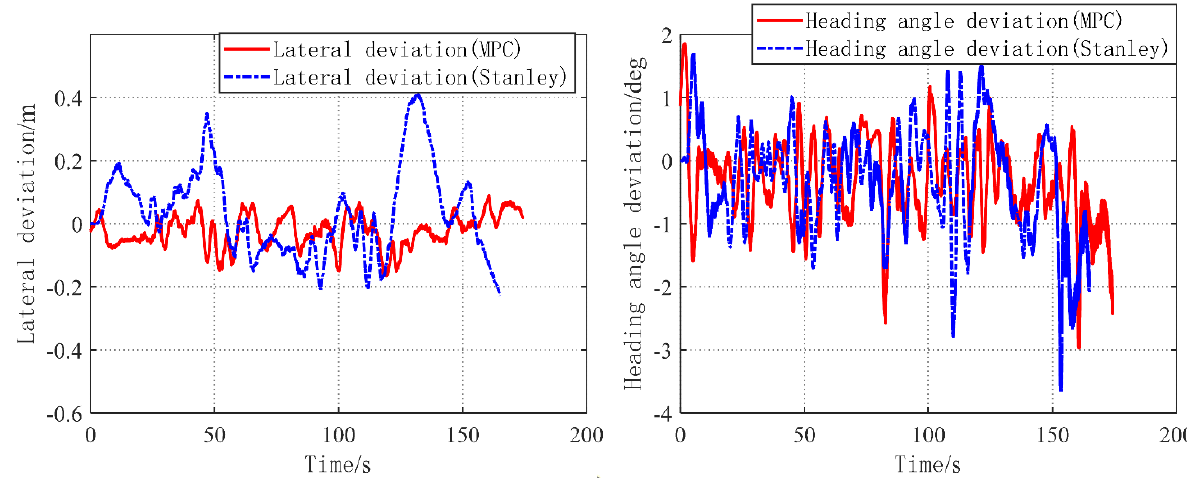
Figure 18. Lateral error and heading angle deviation of MPC control and Stanley control.